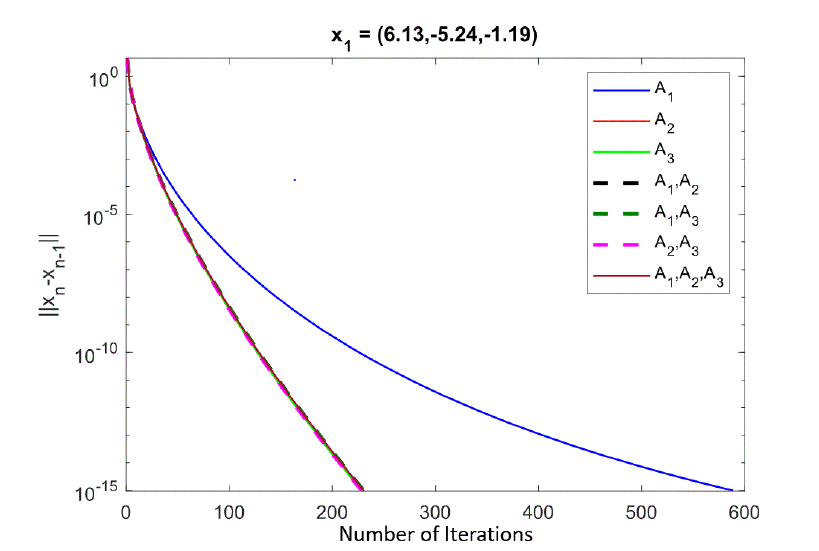
Figure 2. The error plotting (cid:107) x n − x n − 1 (cid:107) for choice 2 in Example 1.